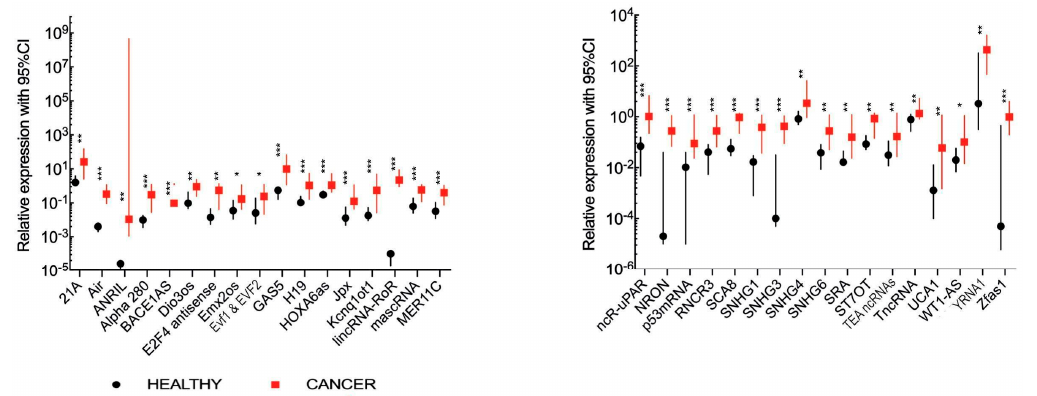
Figure 1. Significantly higher ( p < 0.05) expression levels of 34 plasma lncRNAs between healthy volunteers (black) and head and neck squamous cell carcinoma (HNSCC) patients (red). Squares and circles represent means of expression and lines indicate 95% CI; * p < 0.05, ** p < 0.01, *** p < 0.001.